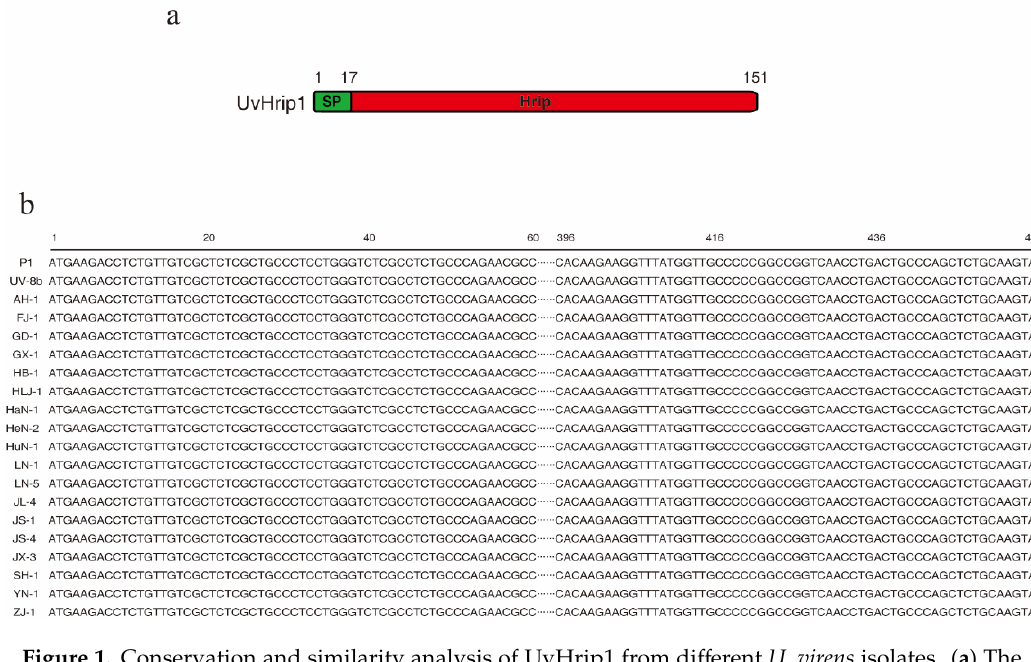
Figure 1. Conservation and similarity analysis of UvHrip1 from different U. virens isolates. ( a ) The predicted structures of UvHrip1 with 151 amino acids. SP, signal peptide; Hrip, hypersensitive response-inducing protein. ( b ) Sequence alignment of the uvhrip1 genes from 20 different U. virens isolates collected from America and different regions in China. The uvhrip1 gene sequences of UV_8b isolates were downloaded from PubMed, others were determined by sequencing.